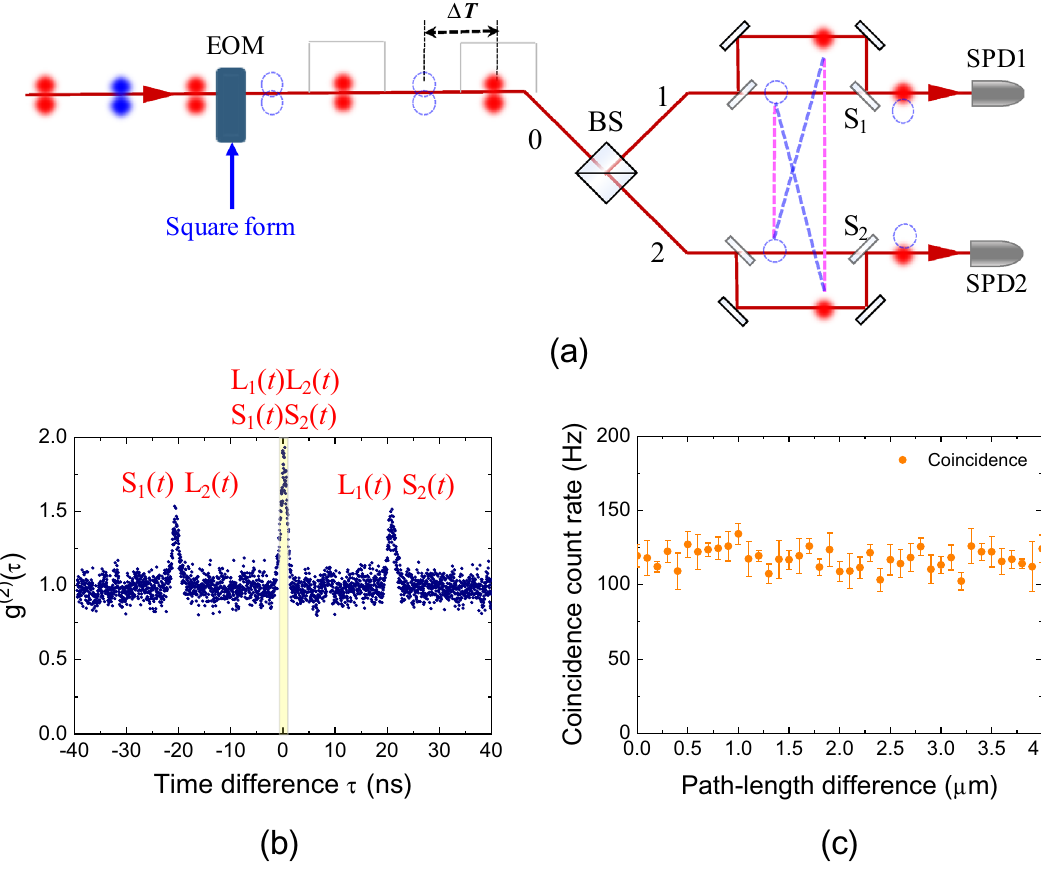
Figure 5. Absence of TSPT state with Δ T in Franson-type interferometry. ( a ) Possible coincidence events of both SPDs at τ = 0 with the switching off of the photons (blue circles) after Δ T from the instant of switching on of the photons (red circles). ( b ) Temporal waveform of thermal photons in Franson-type interferometer without the TSPT state with Δ T . ( c ) Coincidence count rate as a function of the path-length difference (Δ x 1 or Δ x 2